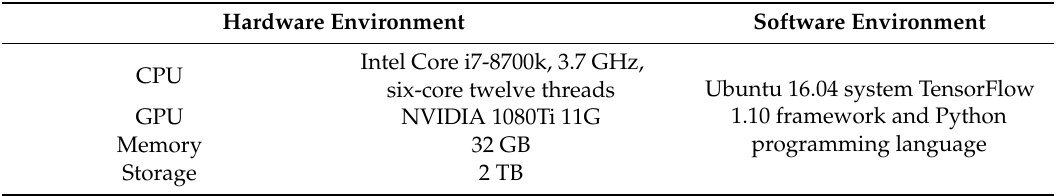
Table 4. The hardware and software environment.